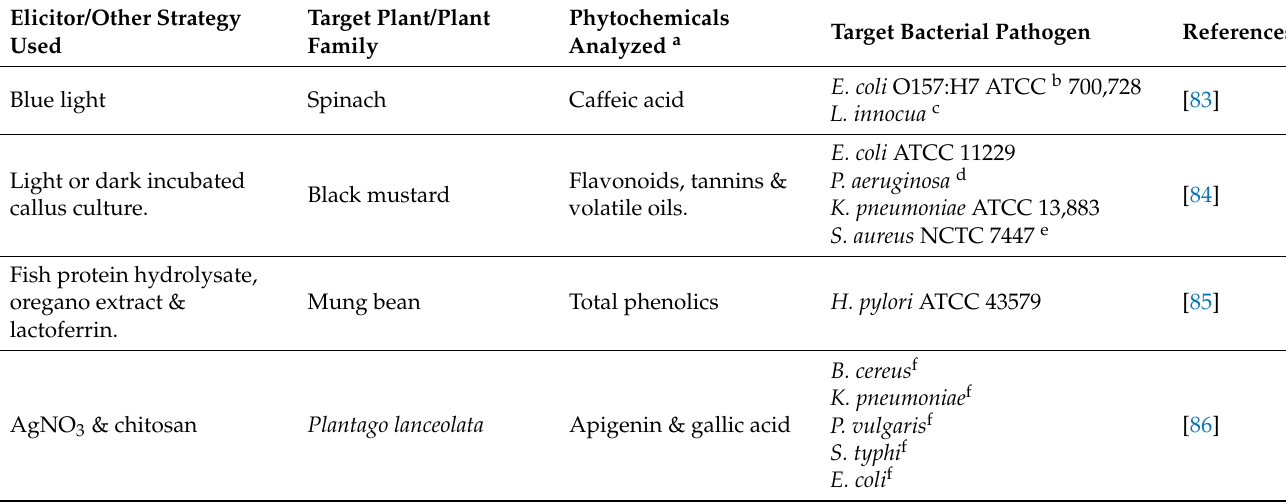
Table 3. Elicitation strategies to enhance phytochemical content and associated antimicrobial activity. Elicitor/Other